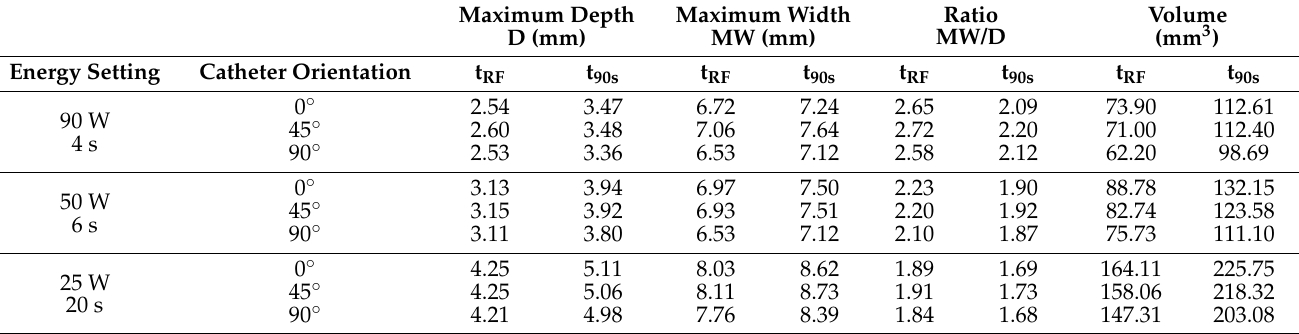
Table 3. Lesion sizes computed for different power–duration settings and catheter orientation just after the RF pulse (t RF ) and at 90 s after the onset of the RF pulse (t 90 ) in the thigh model. Ratio Maximum Depth Maximum Width Volume MW/D (mm 3 D (mm) MW (mm)